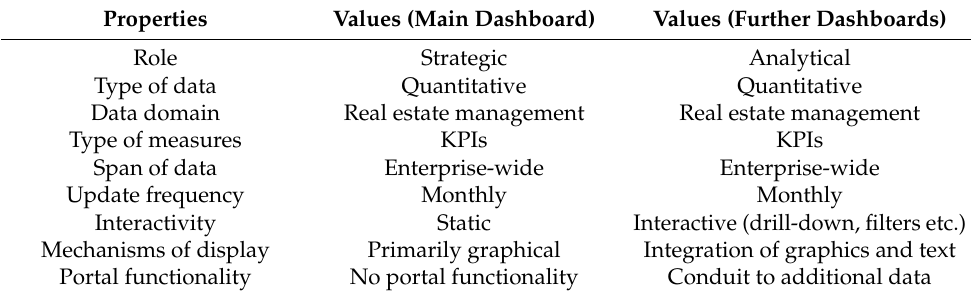
Table 1. Dashboard characteristics (based on Few